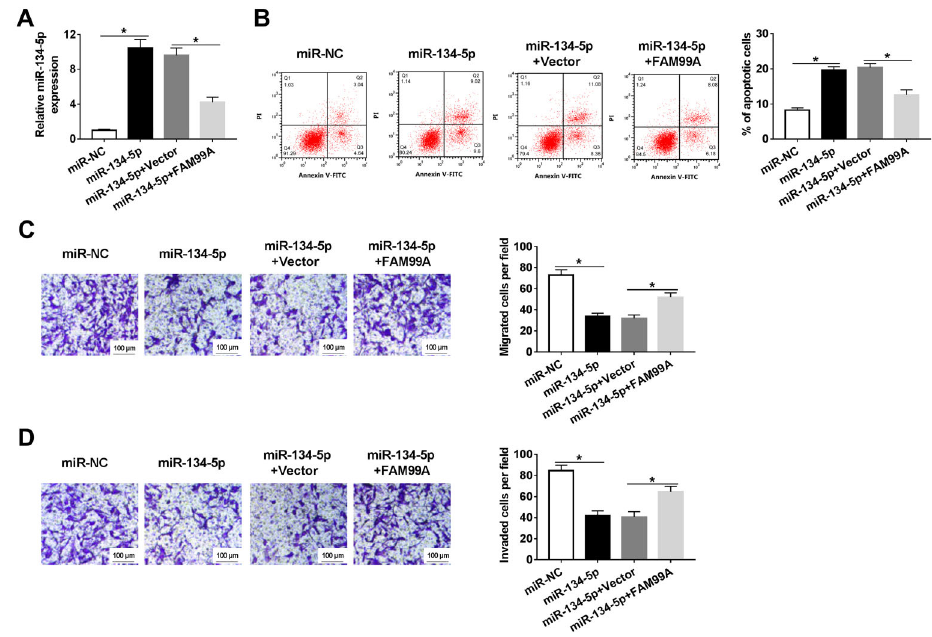
Figure 4. HTR8/SVneo cells were transfected with miR-NC (negative control), miR-134-5p, miR-134-5p + Vector, or miR-134-5p + FAM99A. A , The level of miR-134-5p was detected by qRT-PCR. B , The apoptotic rate was assessed by fl ow cytometry. C and D , The migrated and invaded cells per fi eld were calculated by Transwell assay (scale bar 100 m m). Data are reported as means ± SD. *P o 0.05